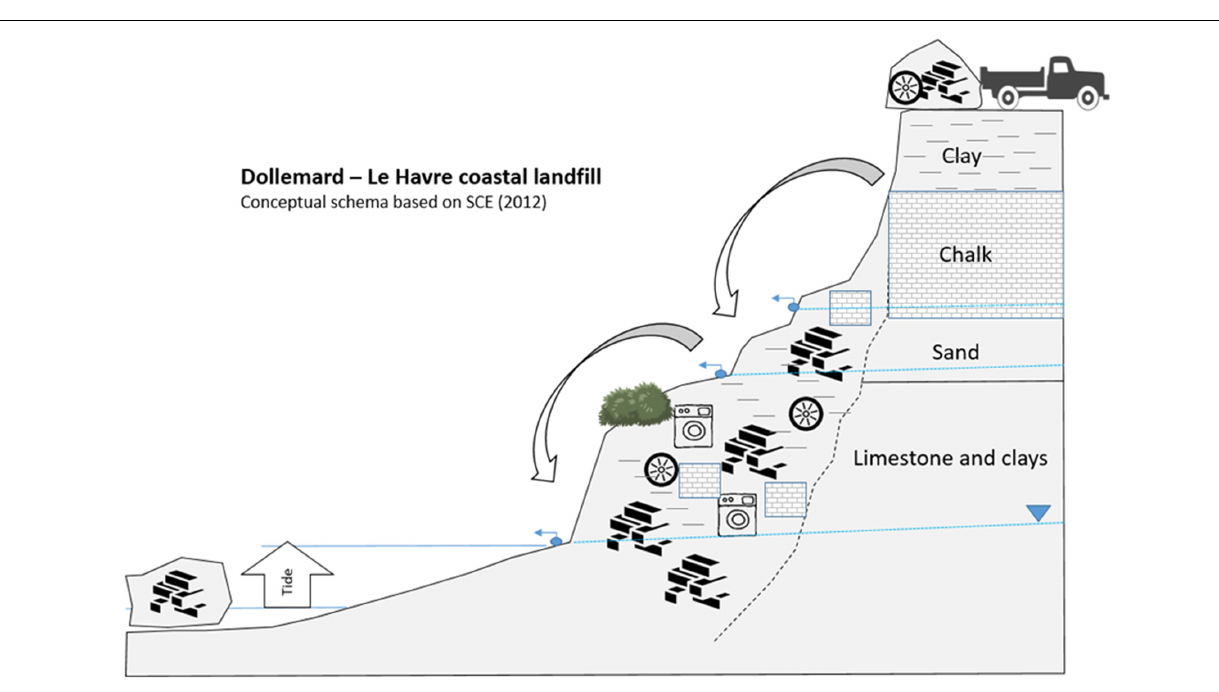
FIGURE 5 | Conceptual cross-section of the Dollemard landfill in Le Havre (France). Adapted from SCE